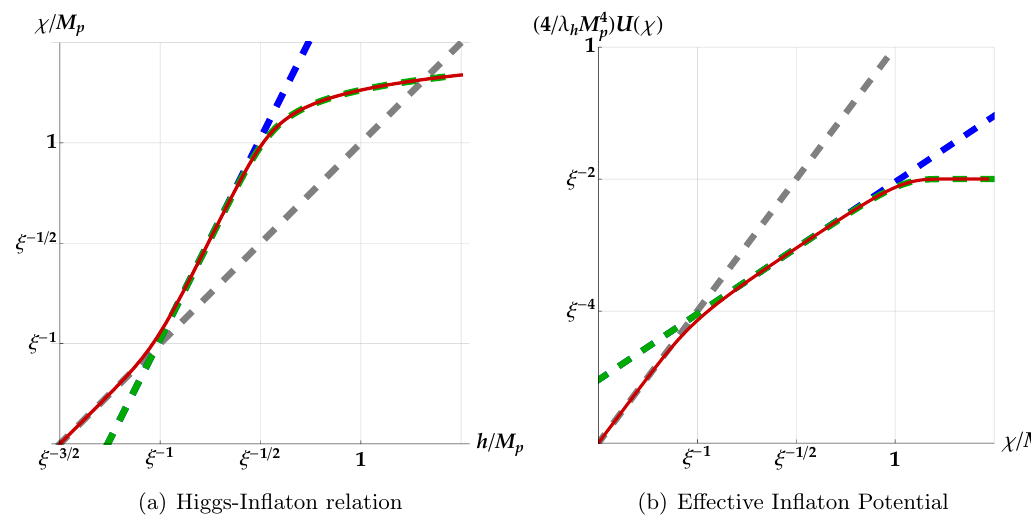
Figure 1 . (a) The relation between the e(cid:11)ective in(cid:13)aton (cid:12)eld (cid:31) and the SM Higgs (cid:12)eld h (red solid line). In the region h=M p (cid:28) (cid:24) (cid:0) 1 , the relation implies (cid:31) (cid:25) h (grey dashed line). In the p region (cid:24) (cid:0) 1 < h=M p , the relation is well approximated by (cid:31)=M p (cid:25) 3 = 2 ln[1 + (cid:24) ( h=M p ) 2 ] (green dashed line), which in the subregion (cid:24) (cid:0) 1 < h=M p < (cid:24) (cid:0) 1 = 2 is further approximated by (cid:31)=M p (cid:25) p 3 = 2 (cid:24) ( h=M p ) 2 (blue dashed line). (b) The e(cid:11)ective potential U ( (cid:31) ) = U 0 ( h ) = (cid:10) 4 ( h ) (red solid line), where U 0 ( h ) = (cid:21) h h 4 = 4 and (cid:10) 2 ( h ) = 1 + (cid:24)h 2 =M 2 . In the region (cid:31)=M p < (cid:24) (cid:0) 1 the potential behaves p as U ( (cid:31) ) (cid:24) (cid:31) 4 (grey dashed line). For (cid:24) (cid:0) 1 < (cid:31)=M p , the potential matches the behaviour of the Starobinsky potential (green dashed line), which behaves as U ( (cid:31) ) (cid:24) (cid:31) 2 (blue dashed line) in